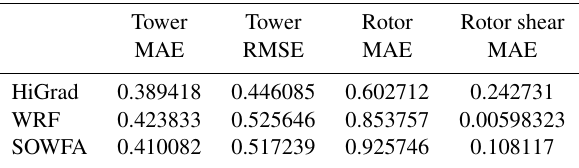
Table 6. Analysis of high-resolution LES performance using dif- ferent models with the Lilly SFS parameterization for the neutrally stratified ABL observed on 17 August